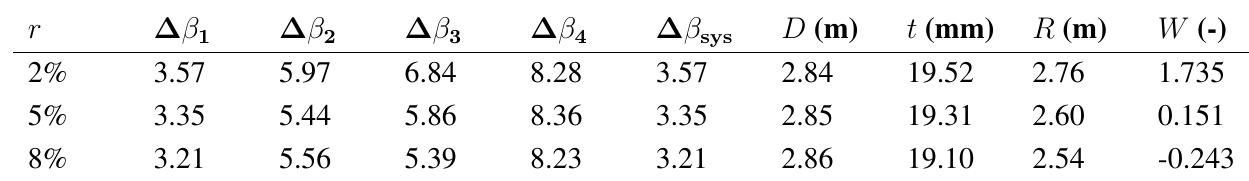
Table 12. Foundation and pile dimensions for Case 2 dependent on real rate of interest r .